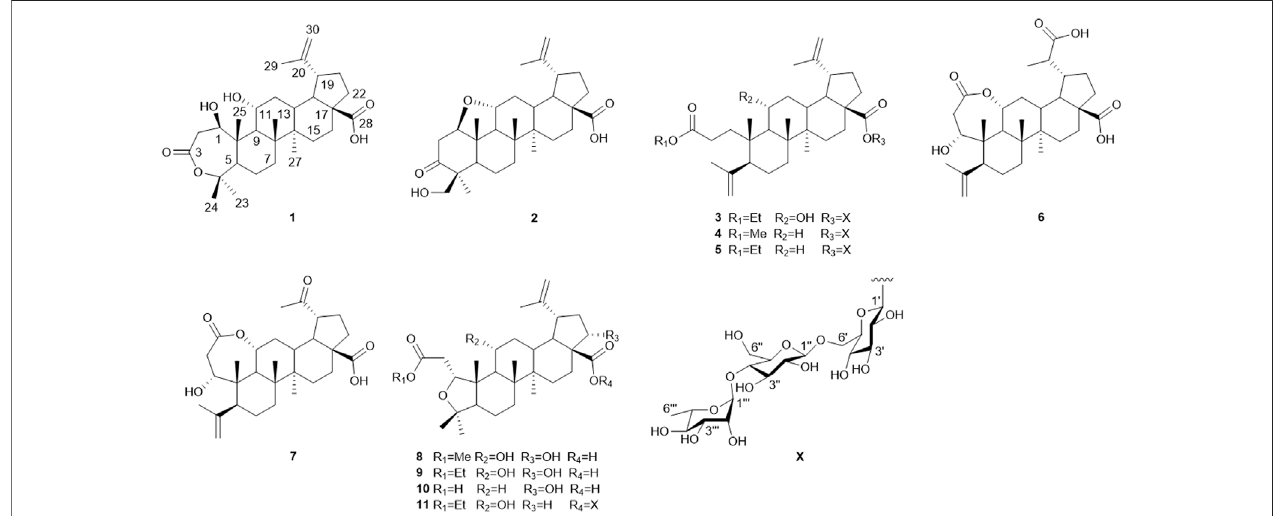
FIGURE 1 | Structures of compounds 1 - 11